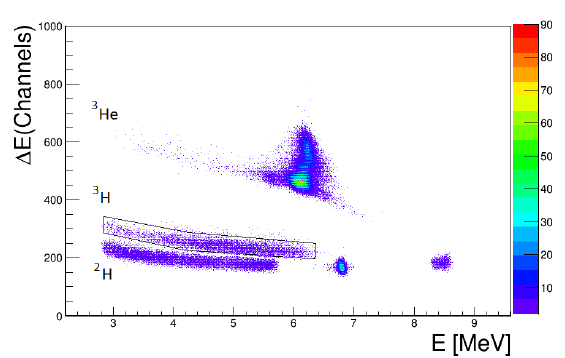
Figure 2. ∆ E / E plot for PSD1 for a typical run of the 2 H( 3 He,pt)H reaction. The black selection represents events identified as